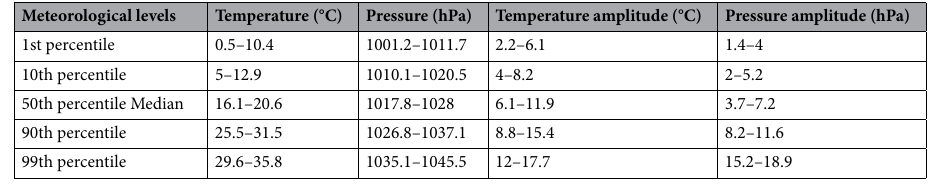
Table 4. Meteorological variable threshold ranges associated to selected levels for this study. Levels may overlap due to the variability of the distributions on each cluster or